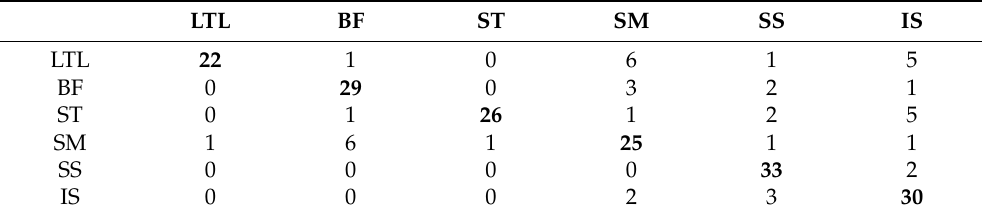
Table 1. Linear discriminant analysis confusion matrix for the classification of individual goat muscle samples analysed intact by near-infrared reflectance spectroscopy. Results correspond to the validation. In bold is the correct number of samples